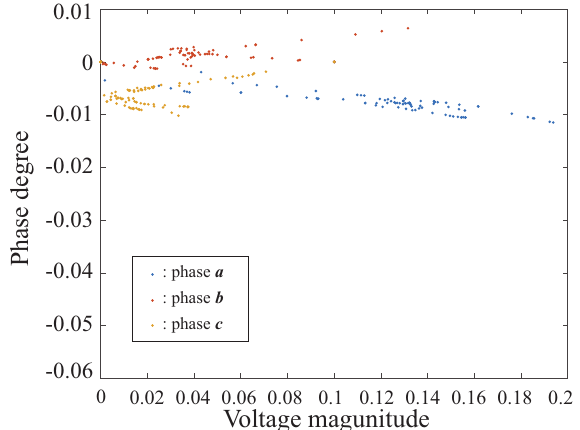
Figure 19. Deviation from base voltage (phasor: magnitude vs. degree) in the case of a heavy load.